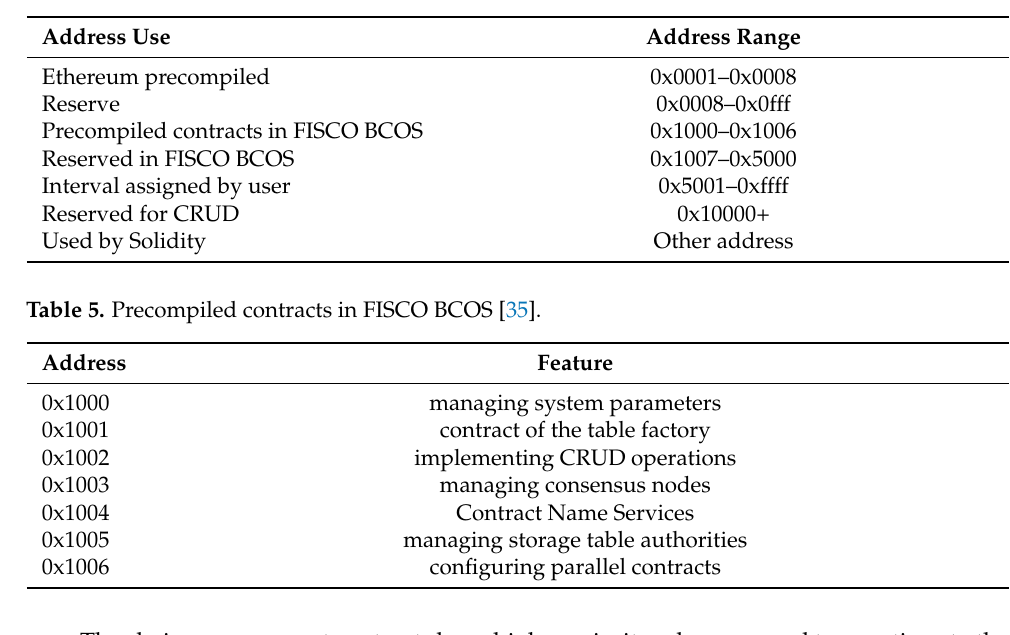
Table 4. Address range in FISCO BCOS [35].